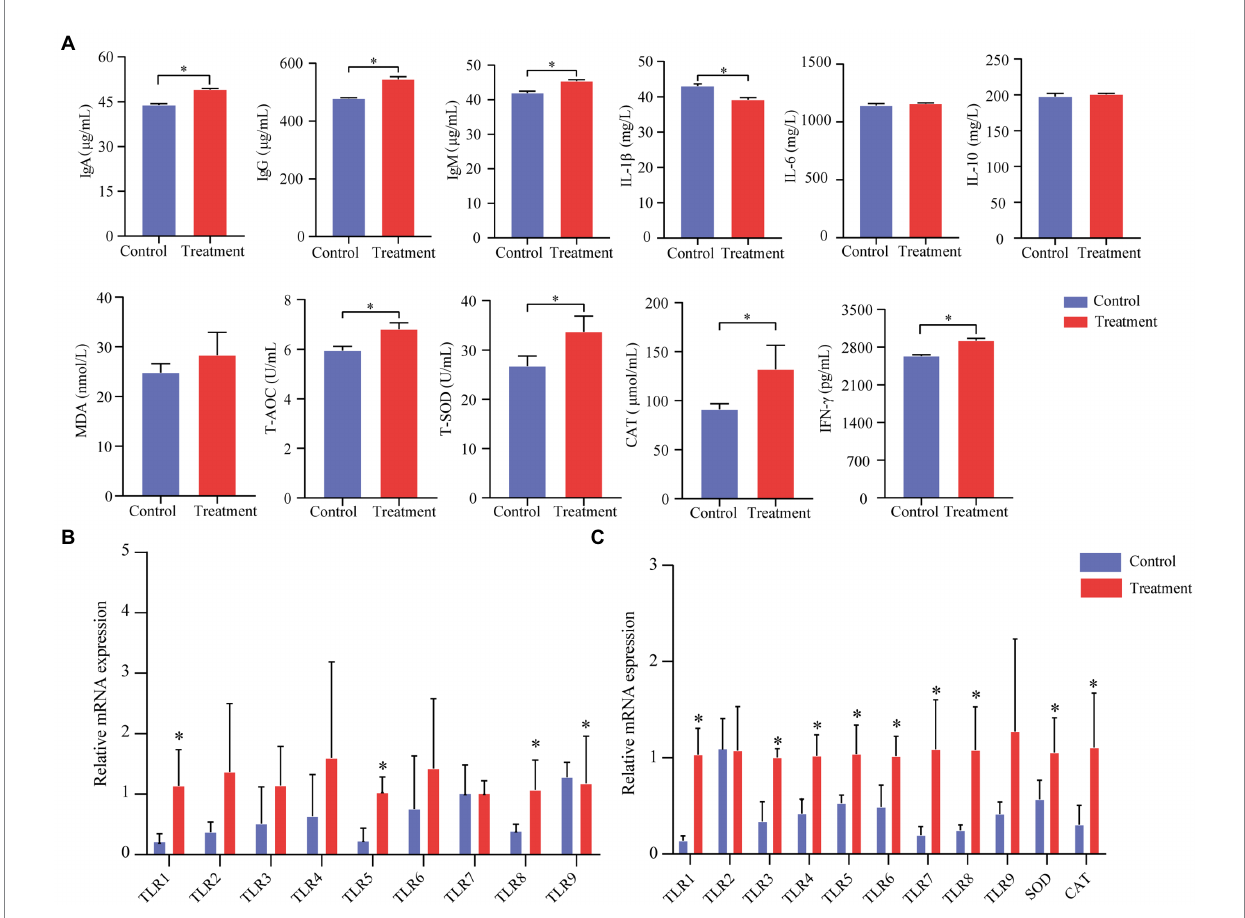
FIGURE 2 Effect of grape pomace on antioxidant indicators and the production of inflammatory cytokines of finishing pigs. (A) Serum levels of indicators including T-AOC, T-SOD, CAT, MDA, IgA, IgG, IgM, IFN- γ , IL-1 β , IL-6, and IL-10 were measured by using ELISA kits ( n = 6). (B) mRNA expression of immune-related genes in the ileum mucosa of finishing pigs ( n = 6). (C) mRNA expression of immune-related genes in the spleen of finishing pigs ( n = 6). Control group, a basal diet; treatment group, a basal diet’s wheat bran is replaced with grape pomace. Data were shown as means ± SD, * refers to significant difference ( p < 0.05). Ig, immunoglobulin; CAT, catalase; TLRs, Toll-like